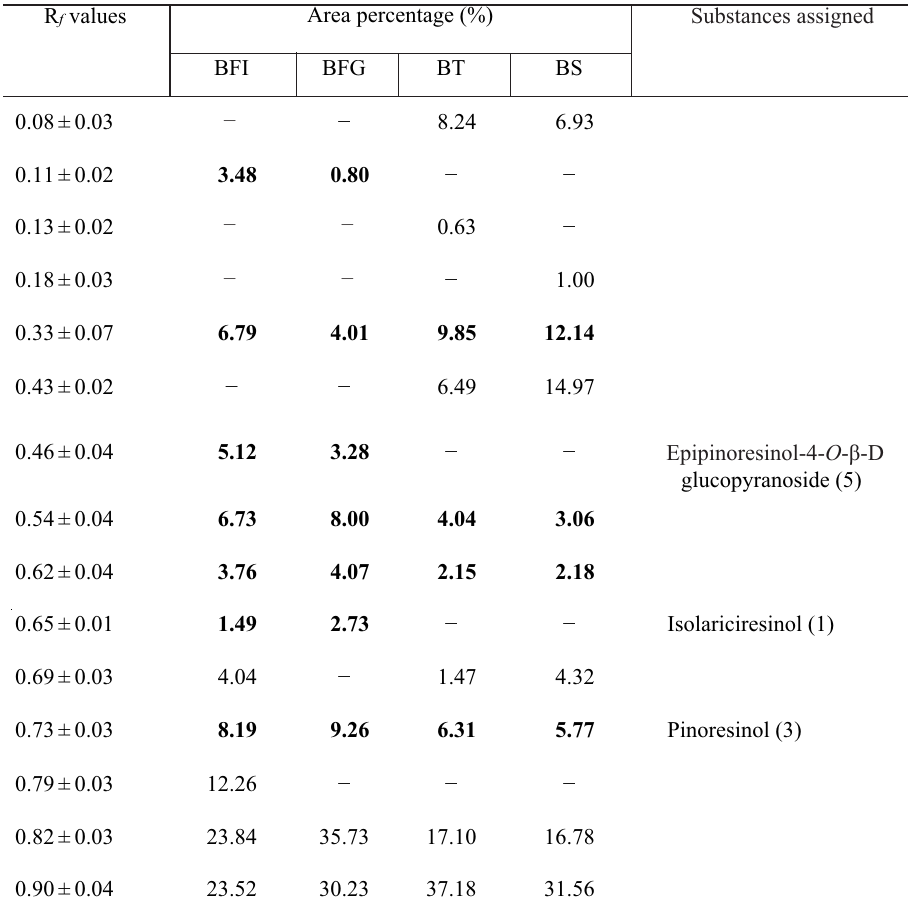
Table 4. Evaluation of the HPTLC fingerprinting profile of the methanol extracts of Balanophora species, developed with the eluent system chloroform–toluene–methanol–25% aqueous ammonia (10:3:6:1) and observed at white light after derivatization with anisaldehyde­sulphuric acid